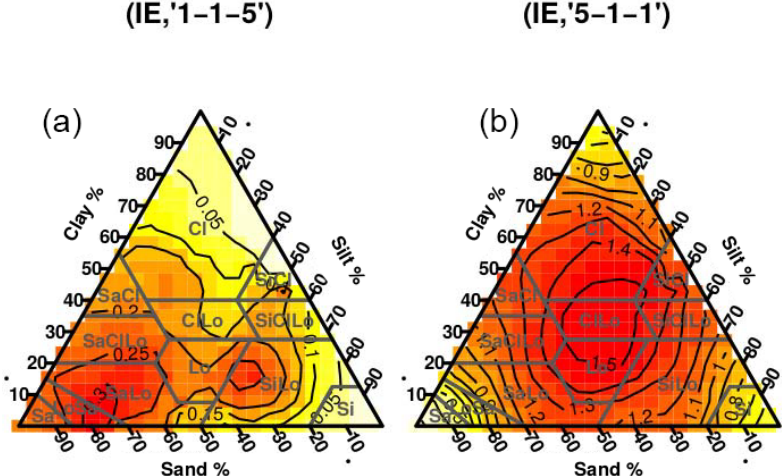
Figure 2. Ternary representations for IE calculated for the soils of the study but using different triplets. The usual clay, silt, and sand triplet (“5-1-1”) was used at panel (a) and the grouping seven textural fractions into “1-1-5” was used as input for panel (b) .